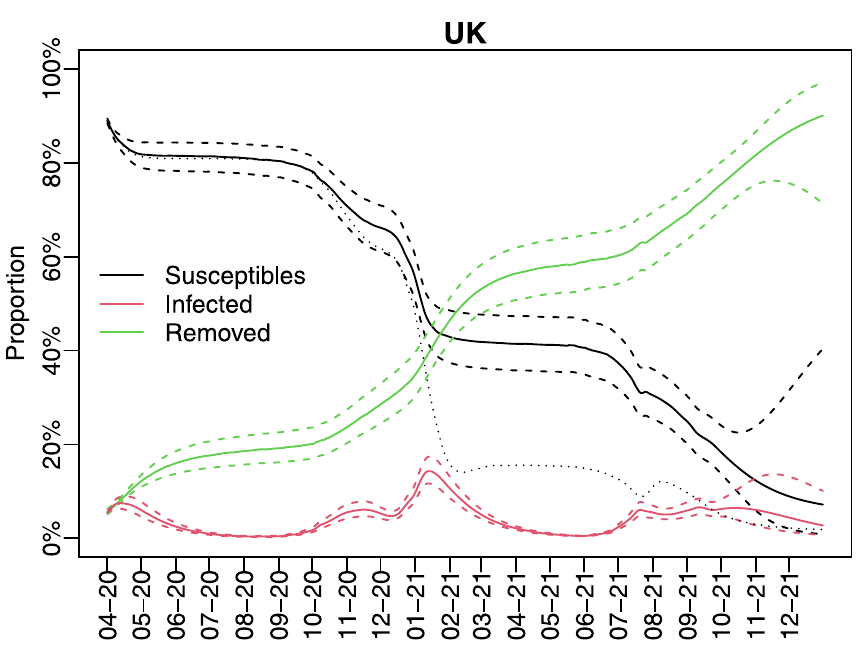
Fig 3. Predicted susceptible, infected and removed proportions (95% CI) and the susceptibles without reinfection (dotted line).